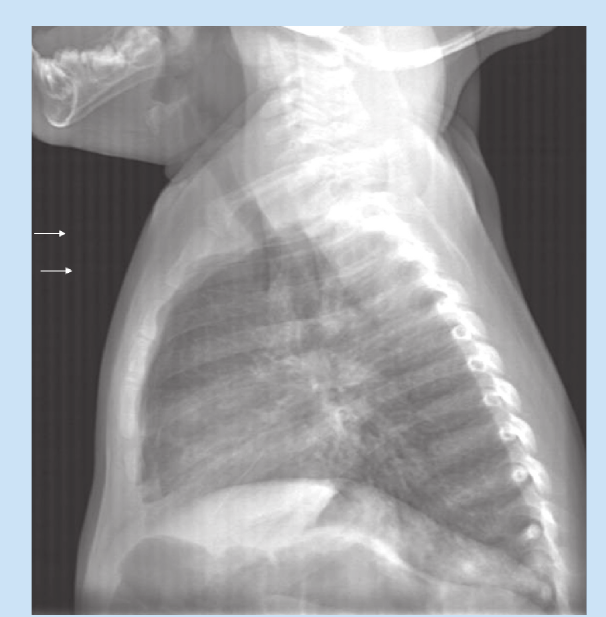
Fig. 2. Image showing the chevron artefact consisting of alternating dark and light bands, indicated by the white arrows.